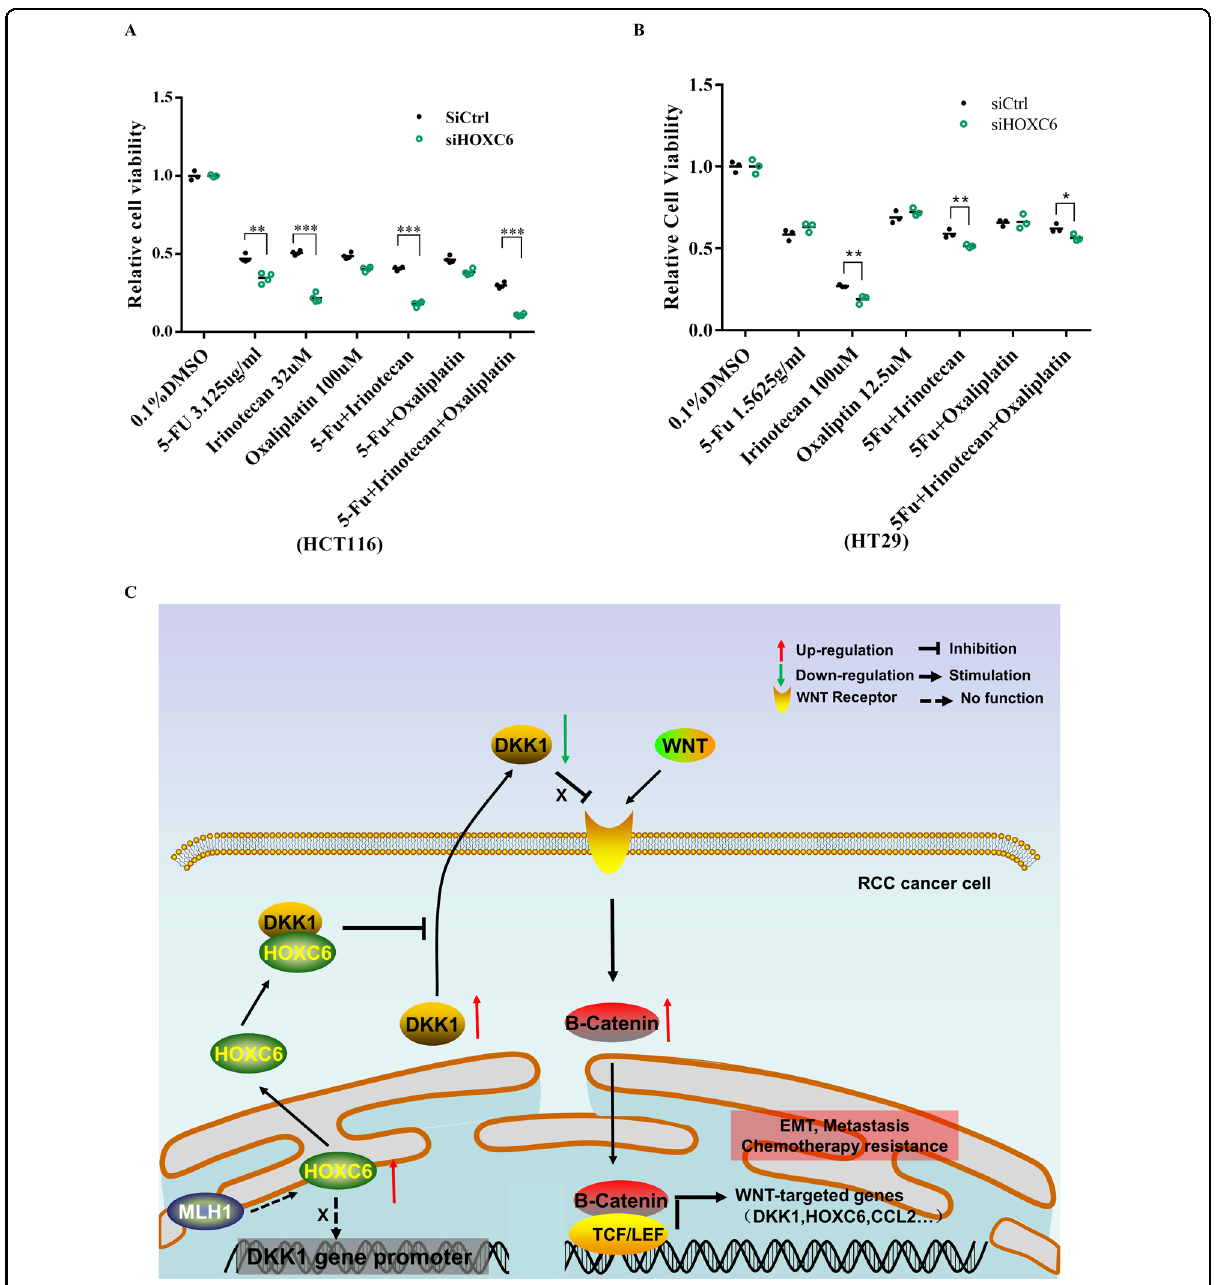
Fig. 6 Inhibition of HOXC6 contributes to enhanced chemotherapy sensitivity. A HCT116 cells in the siHOXC6 group were more sensitive to 5- Fu, irinotecan, 5-Fu + irinitecan and 5-Fu + irinitecan + oxaliplatin compared to those in the siCtrl group. B HT29 cells in the siHOXC6 group were more sensitive to irinotecan, 5-Fu + irinitecan and 5-Fu + irinitecan + oxaliplatin compared to those in the siCtrl group. C Schematic diagram of HOXC6 promote metastasis via DKK1/Wnt/ β -catenin axis in RCC. *: P < 0.05; **: P < 0.01; ***: P <